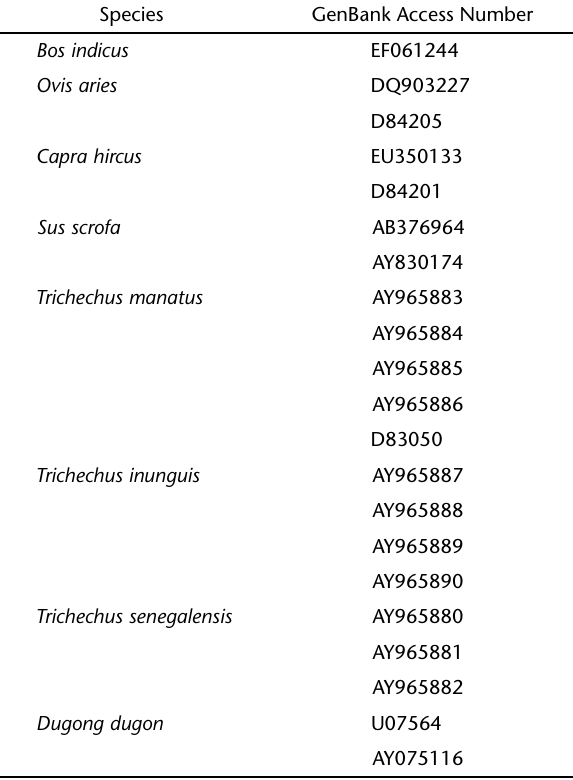
Table I. List of species studied, with GenBank Access Number.